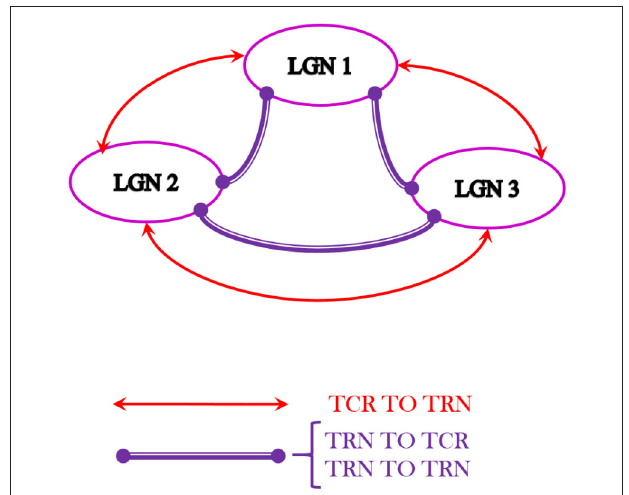
FIGURE 8 | The multi-node LGN model synaptic layout with three instances of the LGN model shown in Figure 1 , consisting of a total of 420 neurons. The TCR (TRN) cells of each node make excitatory (inhibitory) synapses to the TRN (TCR) cells of every other node. Also, the TRN cells of every node make inhibitory synapses to the TRN cells of every other node. For simplicity, the inter-node synaptic connectivity attributes p conn , w syn , d conn are maintained as in respective pathways of the basic LGN